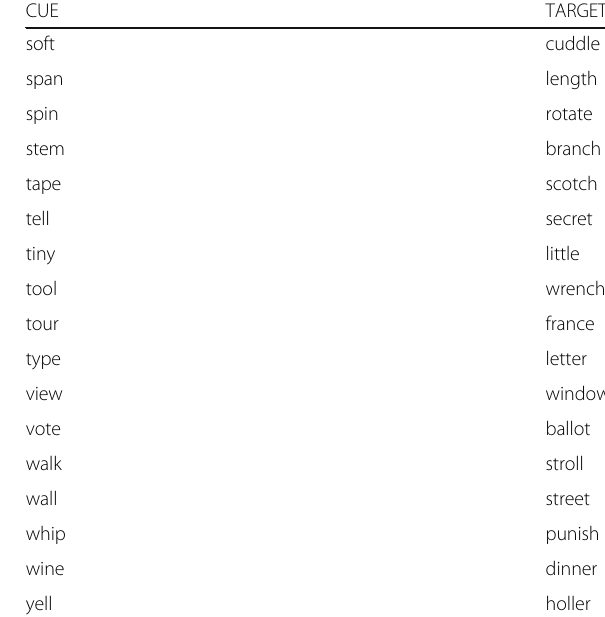
Table 3 Cue-target pairs used in Experiment 4